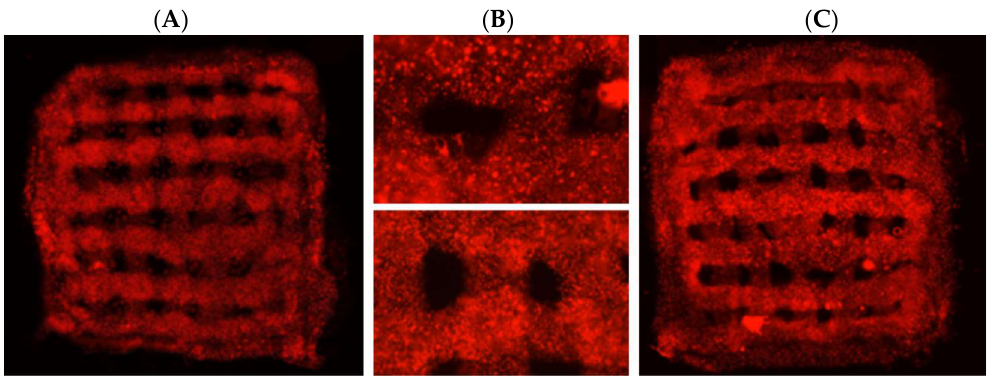
Figure 5. 3D-printed bioscaffolds with red-fluorescent BC cells. ( A ) and ( B ) upper panel—day 1 after printing. ( B ) Lower panel and ( C )—5 weeks after printing. The relocation of cells towards the edge of the printed structure in 5 weeks bioscaffolds is shown.